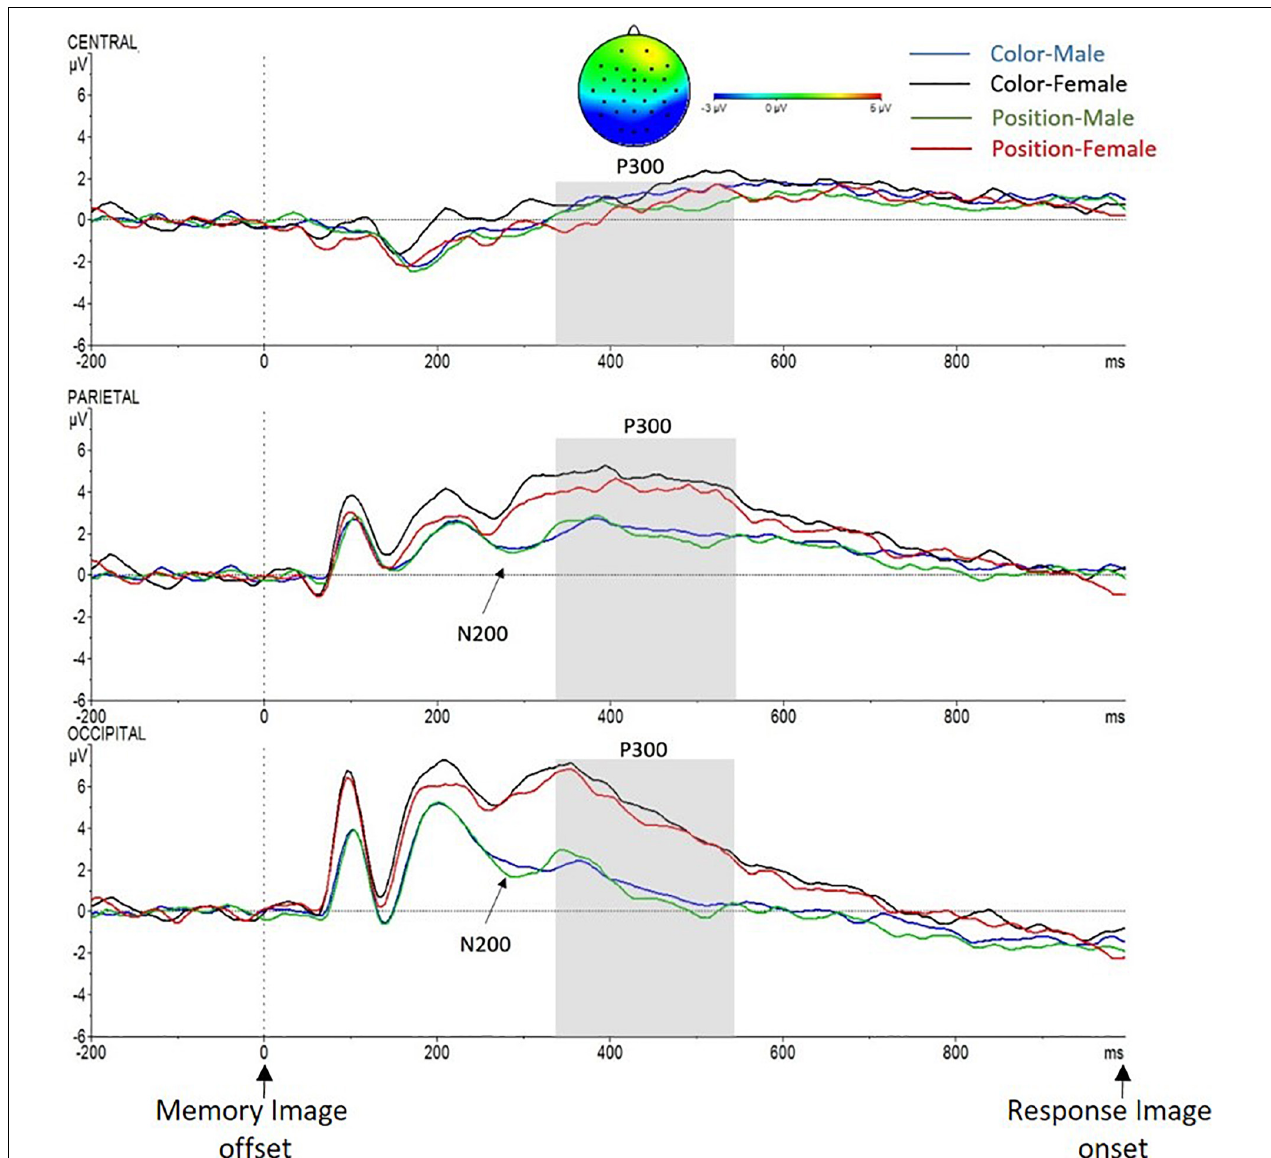
FIGURE 7 | Grand-average voltage data (in mV) of ERP in the Maintenance phase (delay period) in ROI, as a function of Criteria and Sex (Color Men, blue line; Color Women, black line; Position Men, green line; and Position Women, red line). Gray shades represent the P300 time window. On the top, topographic map of the difference in ERP waves due to Sex (Men–Women) in the P300 time window. Time zero represents Memory Image offset.